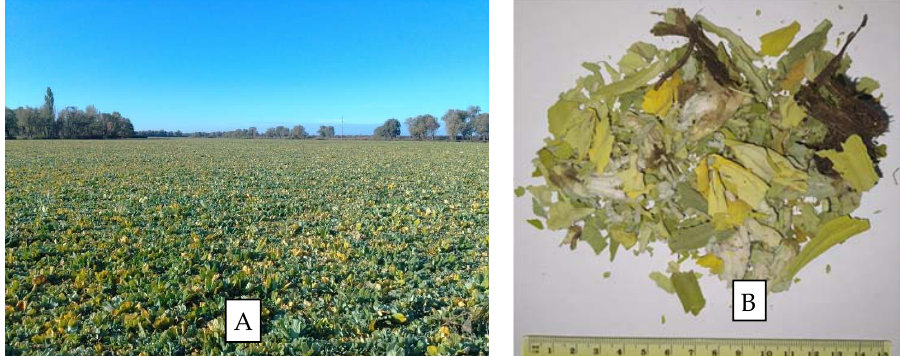
Figure 2. The view of the Pistia stratiotes L. plants on the sampling site ( A ) and after drying ( B ) before loading into the sealed glass jars.